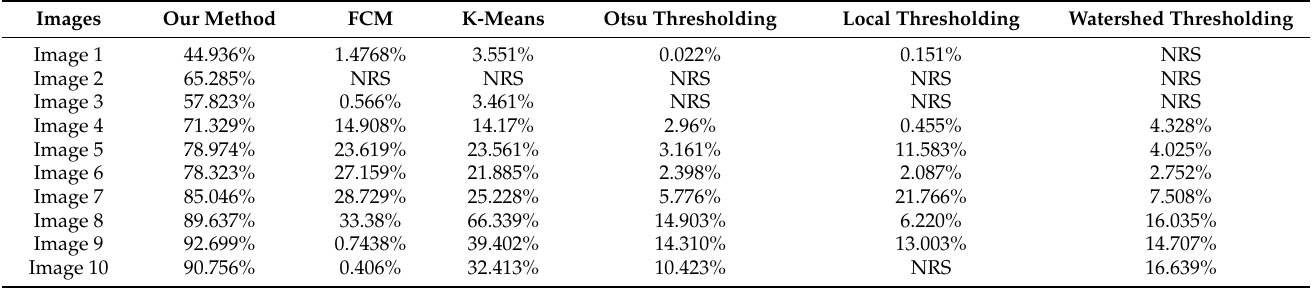
Table 6. Comparison between the results of our segmentation method on the KICA dataset and some well-known segmentation techniques using the Jaccard distance.